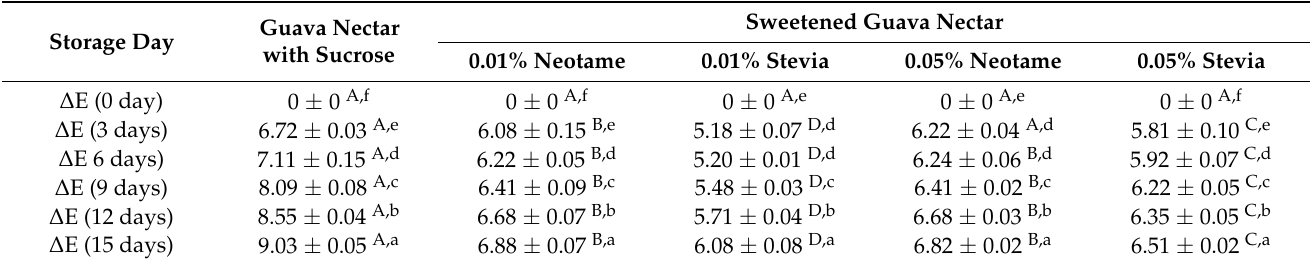
Table 3. The color change of guava nectar and sweetened guava nectar during 15th of storage day at 5 ◦ C.